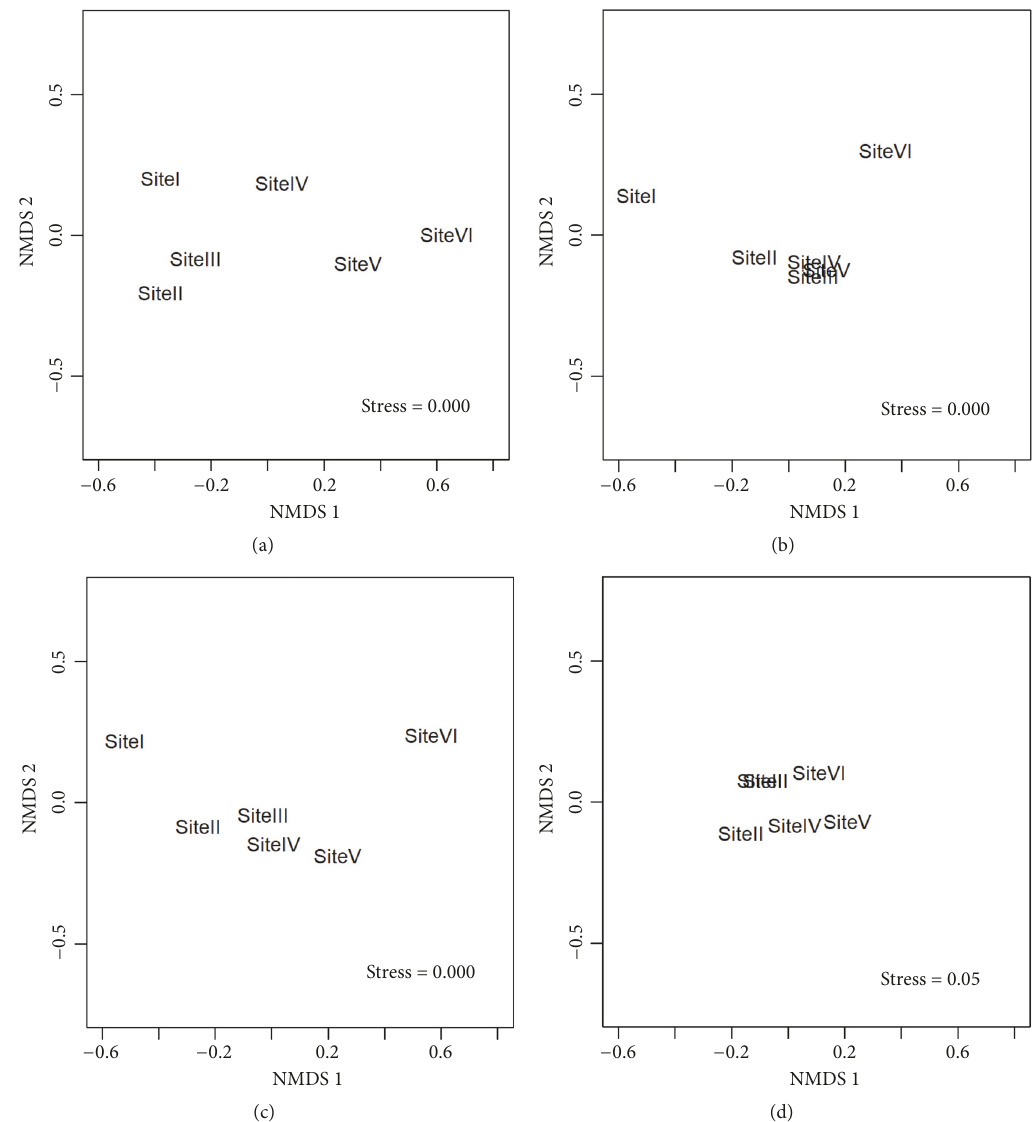
Figure 12: Nonmetric Multidimensional Scaling of the sites for (a) Janajagaran BZCF, (b) Musharni Mai BZCF, (c) Radha Krishna BZCF, and (d) Parsa Wildlife